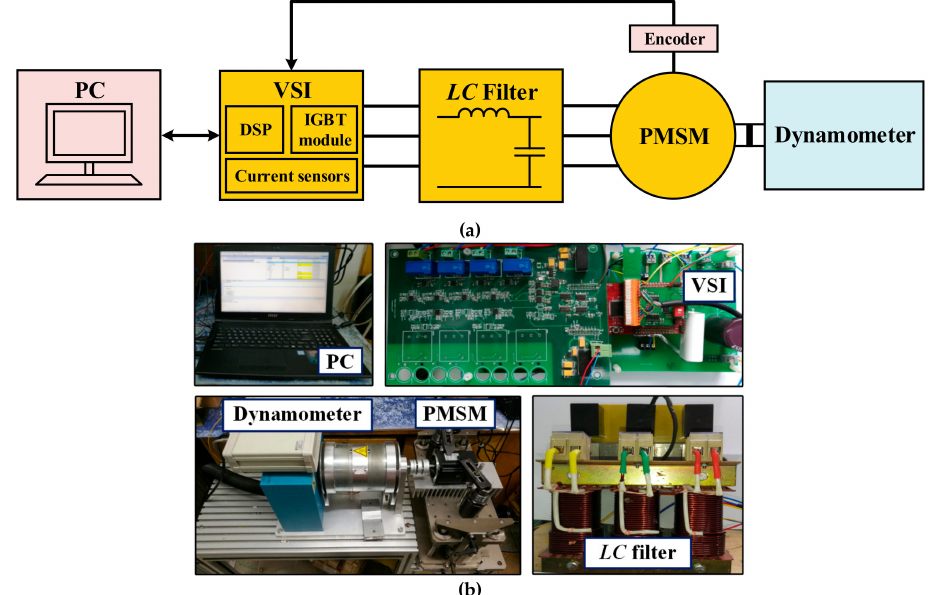
Figure 6. Experimental setup. ( a ) Scheme diagram; ( b ) photograph.